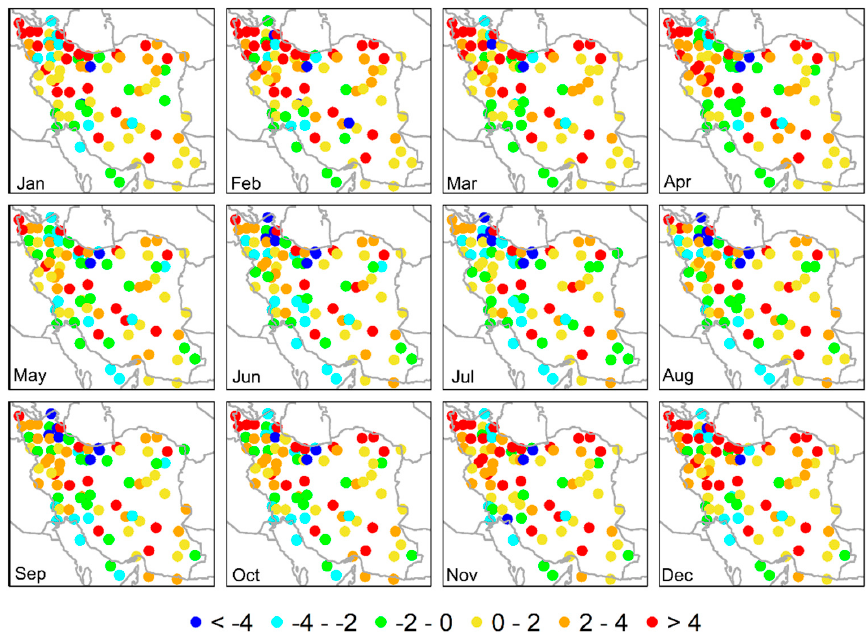
Figure 5. Deltas (°C) between monthly Princeton and observed monthly minimum temperature from 1988 to 2012.